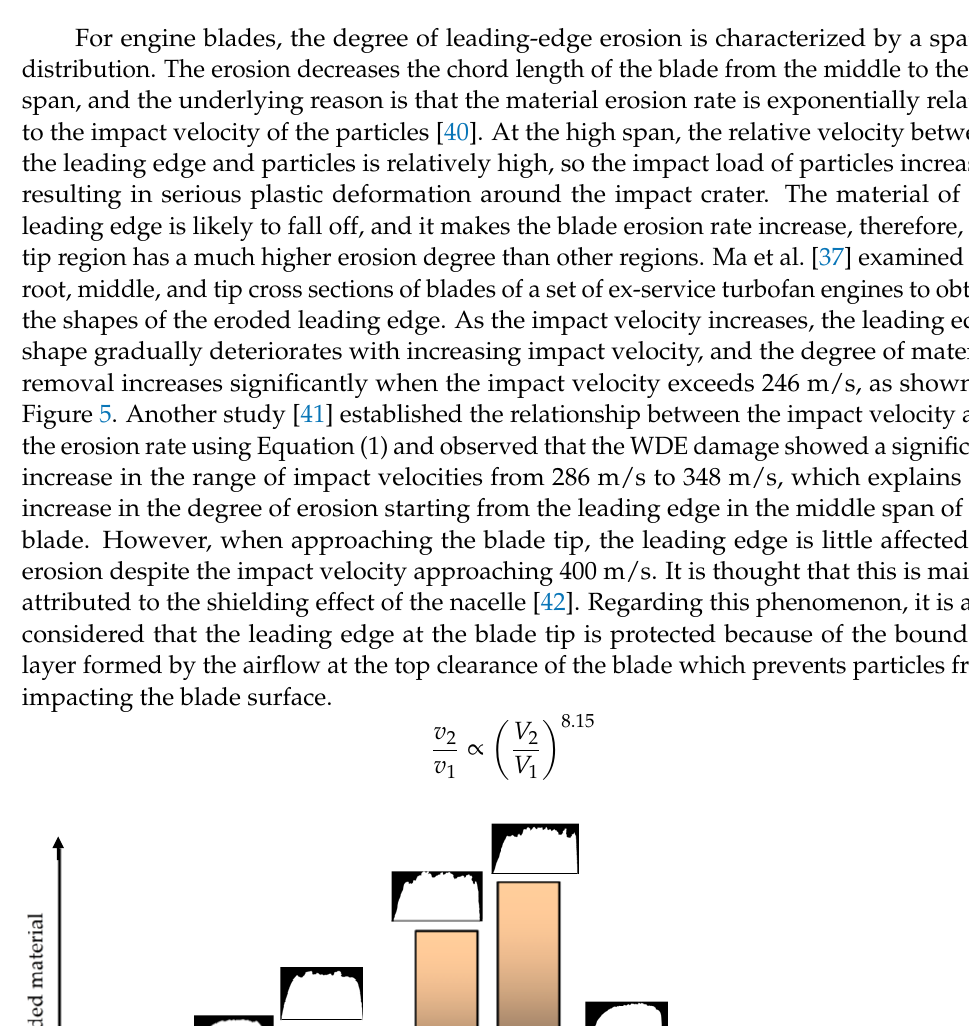
the radius of the leading edge degrades to less than twice, its aerodynamic performance